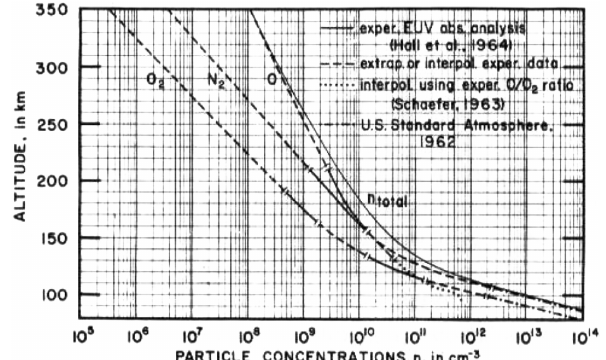
Figure 12. Neutral density profiles of molecular and atomic oxygen and of molecular nitrogen are computed from sequential EUV spec- tral recordings during a rocket mission (reprinted from Hinteregger et al., 1965; copyright permission granted by Elsevier